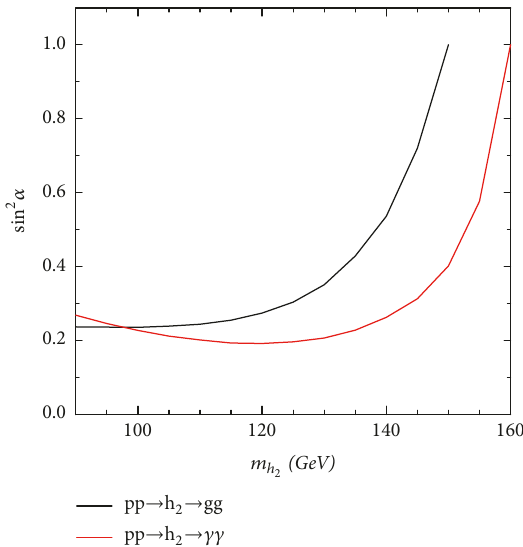
Figure 2: Direct constraint on mixing angle from decay modes 󳨀→ 𝛾𝛾 [34] and ℎ 󳨀→ gg [32, 33] at the 8 TeV LHC, which is ℎ 2 2 verified to be much weaker than indirect constraint from precision tests on SM